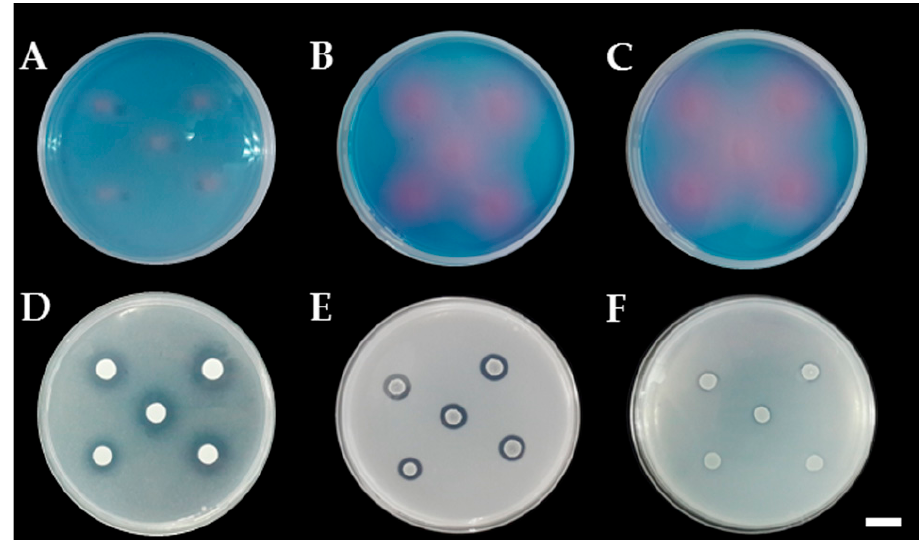
Figure 4. Color change zone on chrome azurol S (CAS) agar of siderophore production of P. laurentii SDBR-CMU-S1-02 ( A ), Wickerhamomyces sp. SDBR-CMU-S2-14 ( B ), and Ap. scarabaeorum SDBR-CMU-S3-02 ( C ). ( D – F ); clear zone of minerals solubilization, Ca 3 (PO 4 ) 2 solubilization by W. anomalus SDBR-CMU-S1-06 ( D ), ZnCO 3 solubilization by W. anomalus SDBR-CMU-S1-06 ( E ), ZnO solubilization by W. anomalus SDBR-CMU-S1-06 ( F ). Scale bar = 10 mm. Table 4. Solubilization of insoluble minerals by yeast strains in this